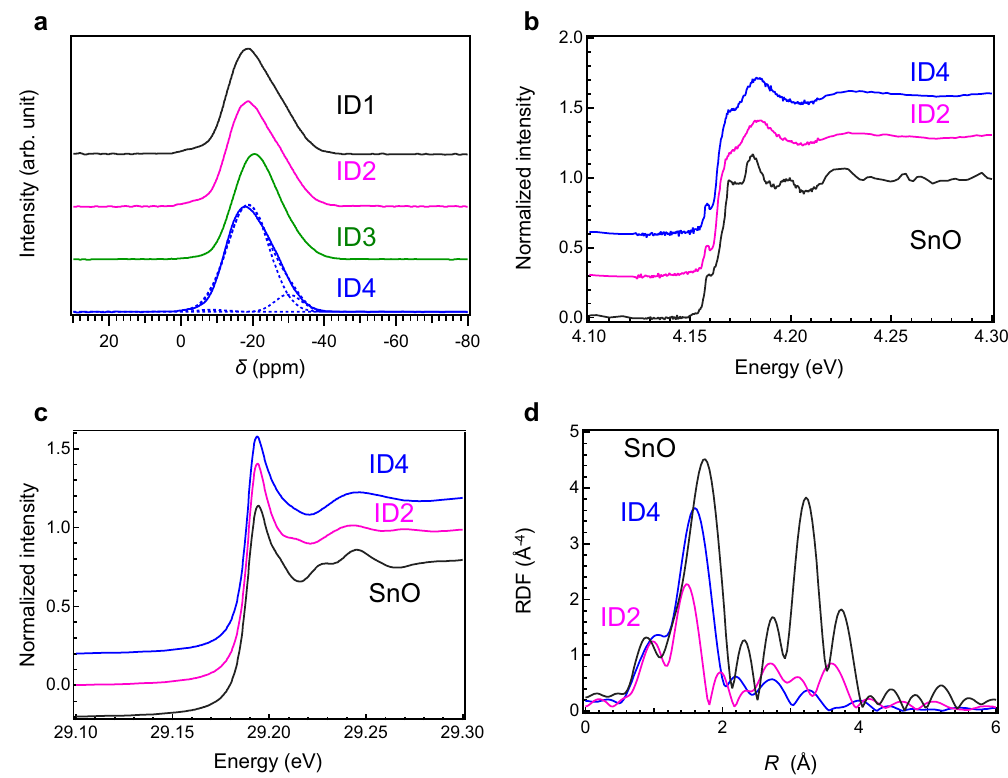
Figure 2. Structural analysis of SnO–P 2 O 5 -based glasses melted at 500 °C for 1 h. ( a ) 31 P MAS NMR spectra of SnO–P 2 O 5 -based glasses. Dotted lines indicate Q 0 , Q 1 , and Q 2 components after peak deconvolution. ( b ) Sn L 2 -edge XANES spectra of SnO–P 2 O 5 -based glasses along with that of SnO. ( c ) Sn K-edge XANES spectra of SnO–P